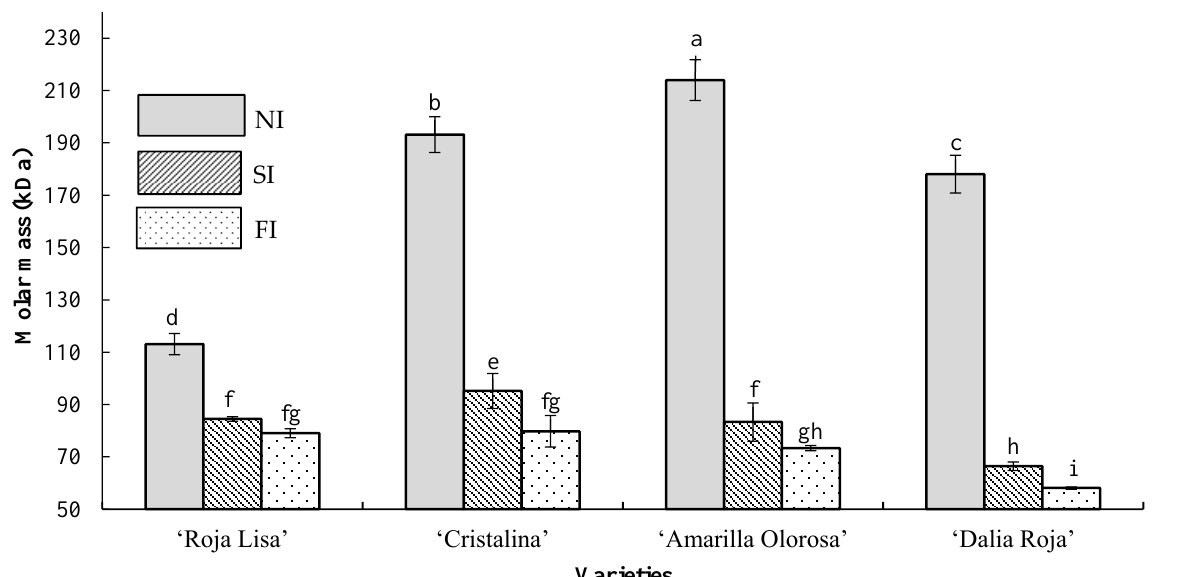
Figure 3. Molar mass (g/mol) of freeze-dried mucilage from Opuntia varieties subjected to three irrigation regimens: no irrigation (NI), supplemental irrigation (SI), and full irrigation (FI). Mean values ( ± standard deviation; n = 3) with different letters indicate statistical differences according to the Fisher’s least significant difference (LSD) test at p ≤ 0.05.